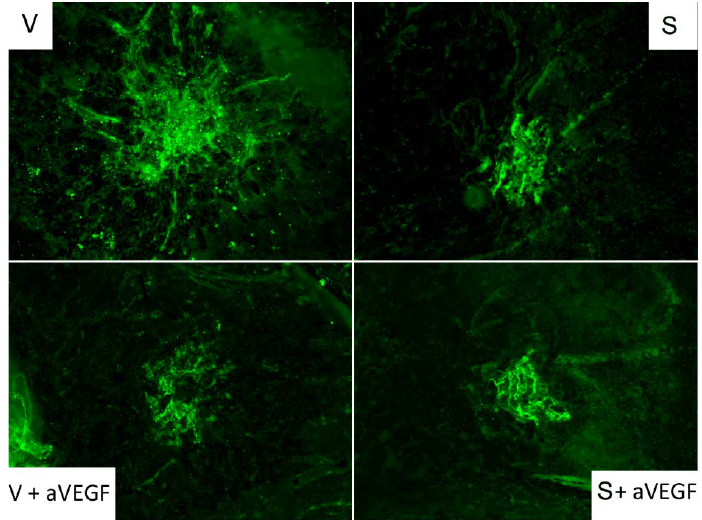
Figure 4. Choroidal neovascularization (CNV) detection by CD31 immunofluorescence. Mice that received only the vehicle (upper left, group V) had larger areas of CNV than mice that received the supplement (upper right) and/or anti-vascular endothelial growth factor (VEGF) treatment. Treatment groups included the nutritional supplement (S) group, the supplement and anti-vascular endothelial growth factor agent (S + aVEGF) group, and the vehicle and anti-VEGF agent (V + aVEGF) group.